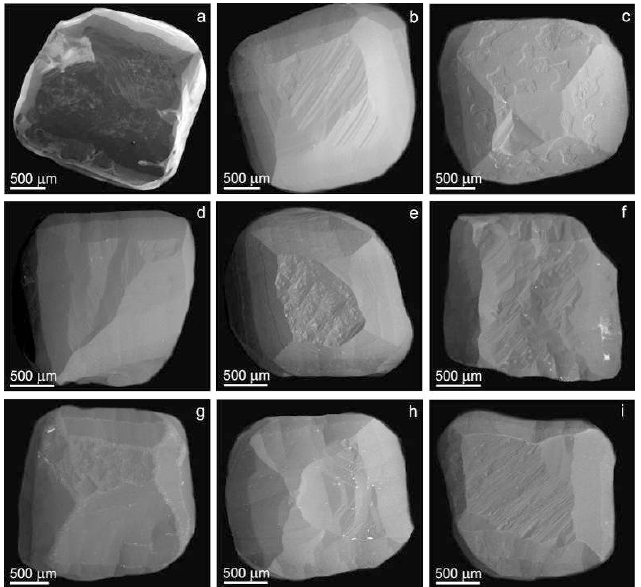
Figure 2. SEM micrographs showing morphological features of cuboid diamonds from the Northeastern Siberian platform ( a —The crystal MP-30 of predominant cubic habit with small rounded tetrahexahedroid surfaces of at the cube edges; b —The crystal MP-43 of combinational form (cube-tetrahexahedroid) with fine striation along <110> on (100) faces; c —The diamond crystal